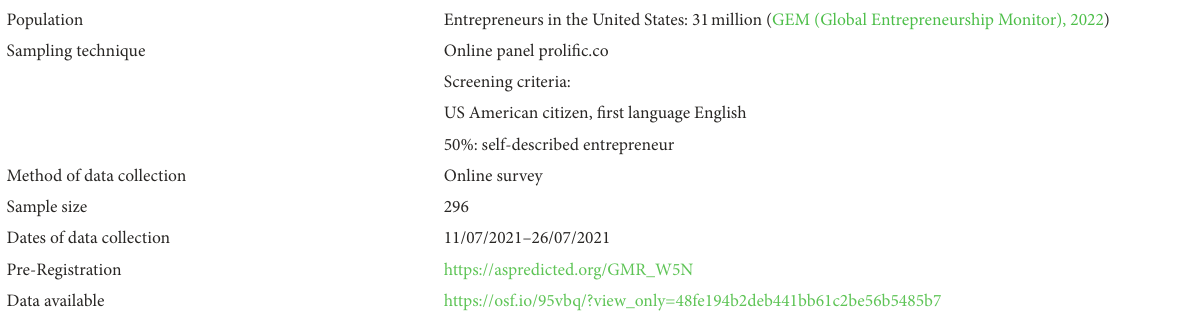
TABLE 2 Technical specifications of the study. Population Sampling technique Online panel